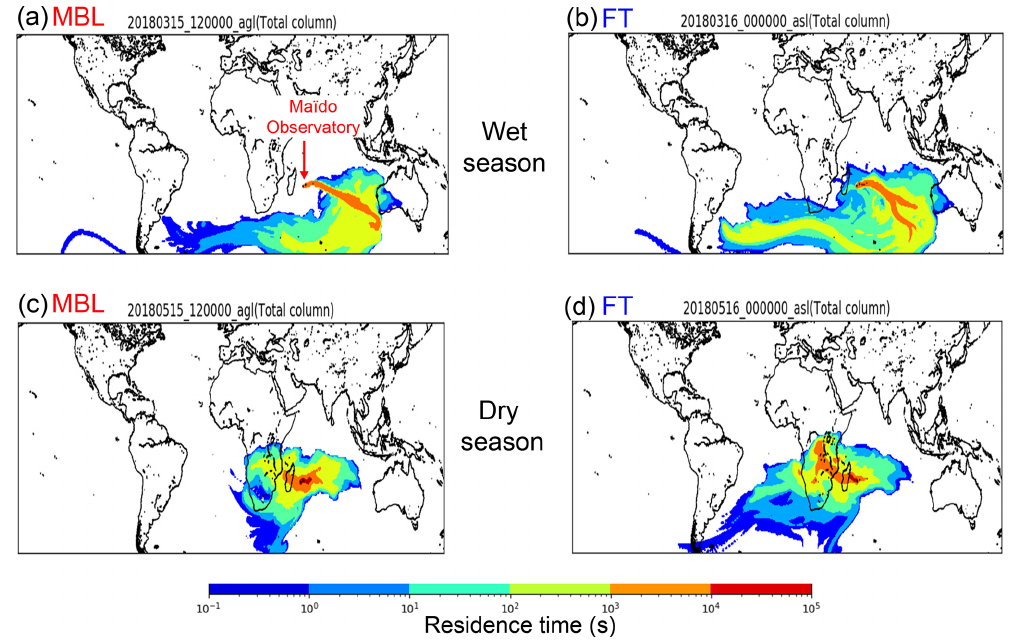
Figure 6. Representative source–receptor relationships for aerosols observed at the Maïdo observatory for a 10d period starting at time under the (a) MBL and (b) FT conditions during the wet season and (c) MBL and (d) FT during the dry season, which were calculated by FLEXPART. The color code represents the surface contribution to the measured air mass at the Maïdo observatory. Each color represents the degree of the surface contribution that varies by a factor of 10. For example, the orange color shows the surface contribution 10 times larger than that shown in